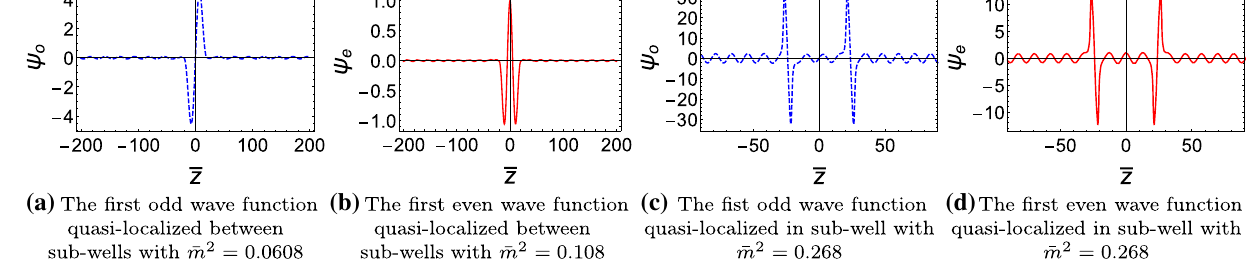
Fig. 26 The KK resonances between sub-wells and in a sub-well with ¯ b = 13, ¯ d = 2 . 3, and ¯ α = − 0 . 00126 for case